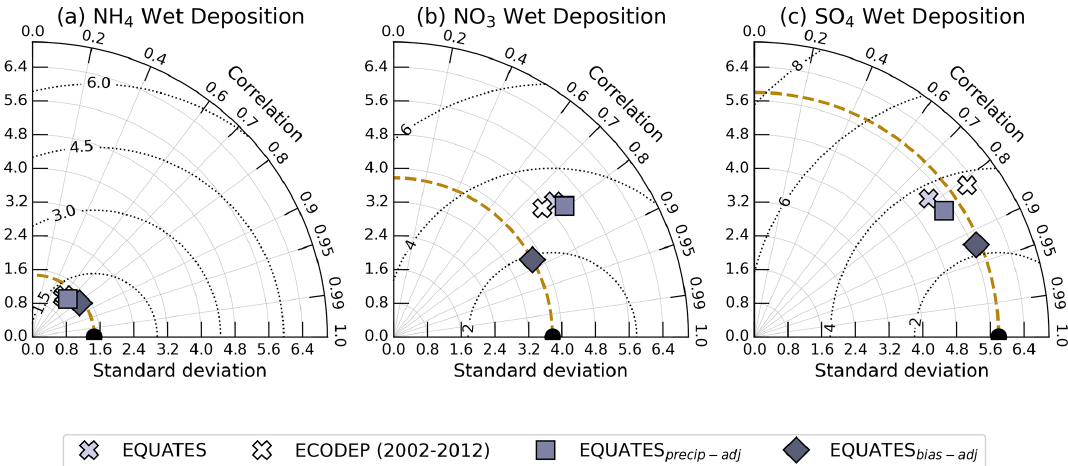
Figure 2. Taylor plot comparing annual accumulated wet deposition (kgha − 1 ) of NH 4 (a) , NO 3 (b) , and SO 4 (c) collected at NTN sites (black circles, along the x axis) with model output. The symbols differentiate between the various models (EQUATES and ECODEP) and wet-deposition corrections as described in the text. The azimuthal angle denotes the Pearson correlation coefficient ( r 2 ); the gold dashed radial distance shows the standard deviation (kgha − 1 ); and the dotted semicircles centered at the observation marker (black circle) denote the root-mean-square error. Table 1. EQUATES model performance metrics of annual (2002–2017) accumulated wet deposition of NH 4 , NO 3 , and SO 4 , including